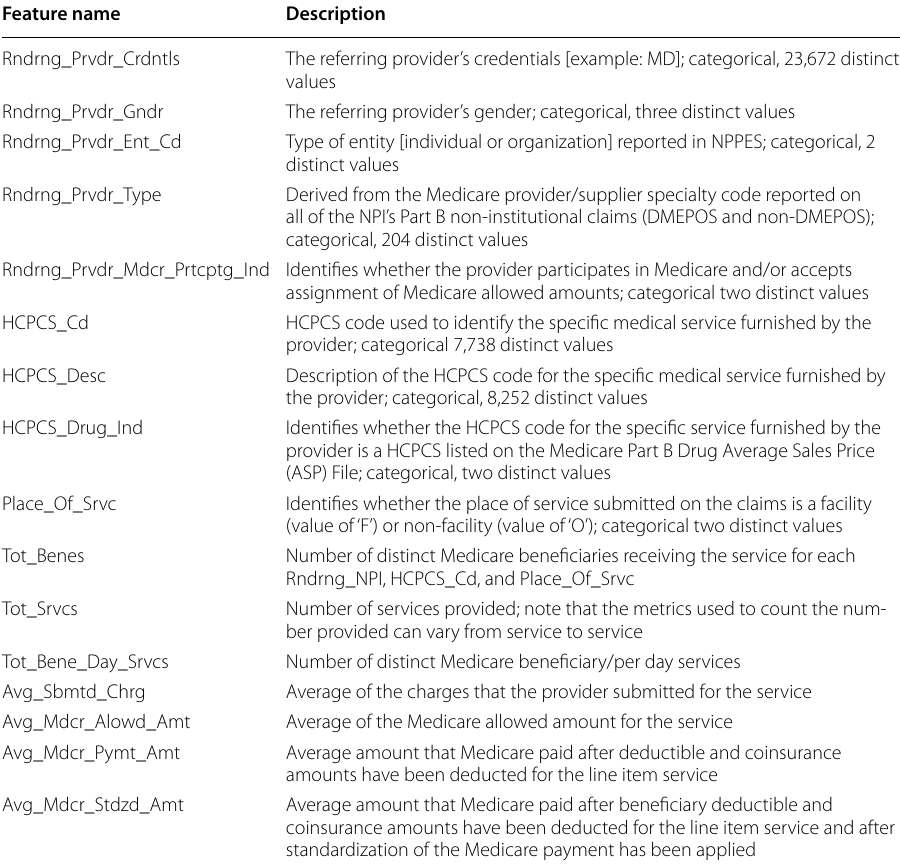
Table 2 Features of the Part B Dataset